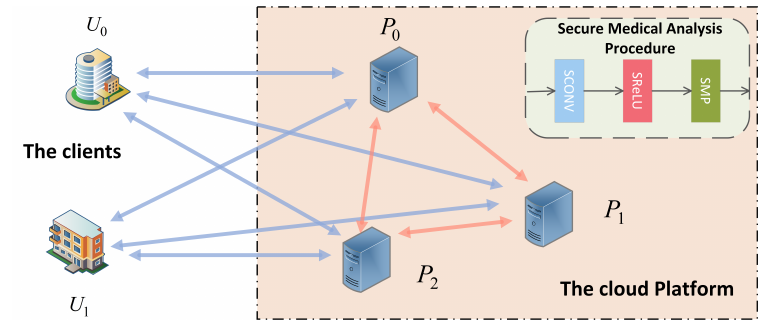
Figure 2. System